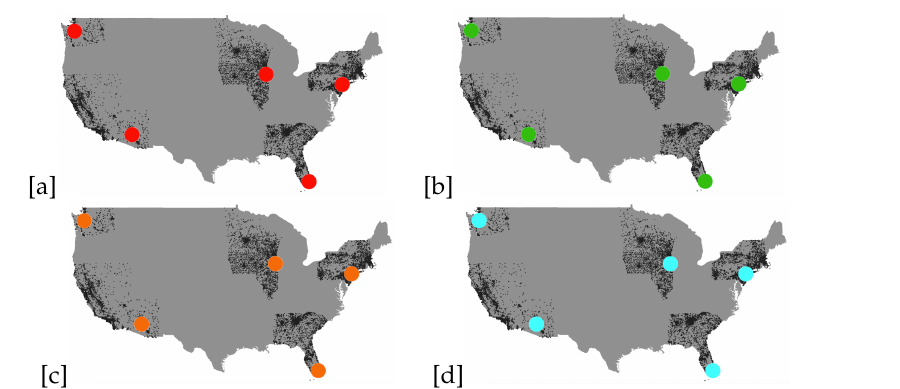
Figure 6. Prototypes found for the partial schools dataset.